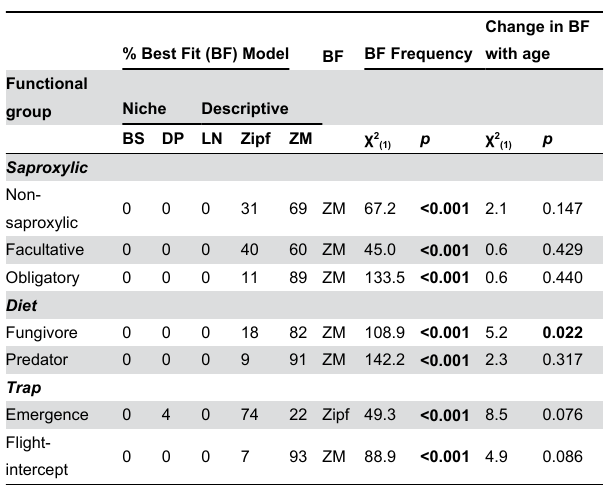
Models are: niche-apportionment models: BS = Broken stick; DP = Dominance pre-emption; and descriptive models: LN = Lognormal; Zipf = Zipf; ZM = Zipf- Mandelbrot. BF = best fit.